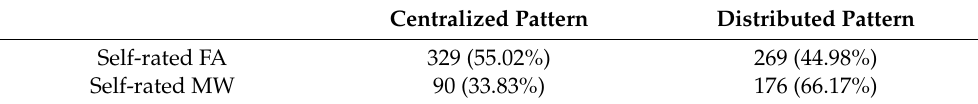
Table A4. Trial numbers across conditions in the subjective measure of MW (response to the